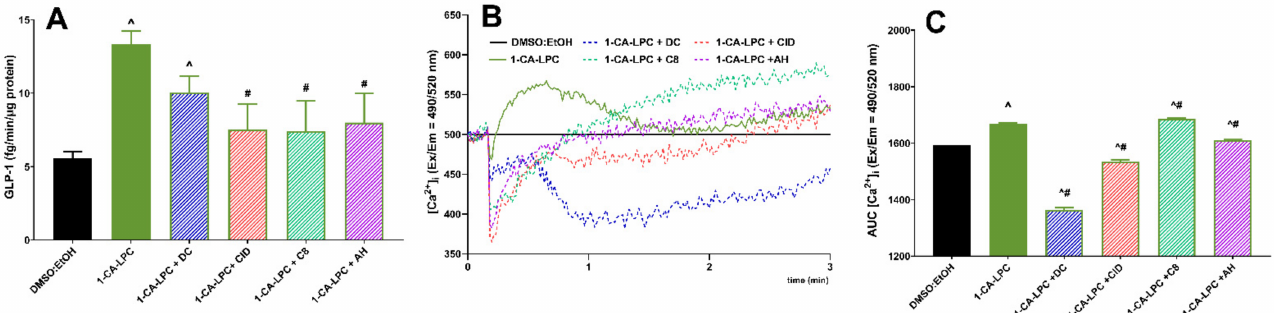
Figure 9. GLP-1 secretion ( A ) and intracellular Ca 2+ mobilization ( B , C ) in GLUTag cells evoked by 1-CA-LPC against GPR40, GPR55, GPR119, and GPR120 antagonists (depicted as DC, CID, C8, and AH respectively). The results are presented as means ( ± SEM) from 4–6 independent experiments, 3–6 biological replicates each, p < 0.05 for GLP-1 secretion and Ca 2+ mobilization was considered as significantly different from DMSO:EtOH control (ˆ) and from GLUTag cells untreated with receptor antagonists ( #